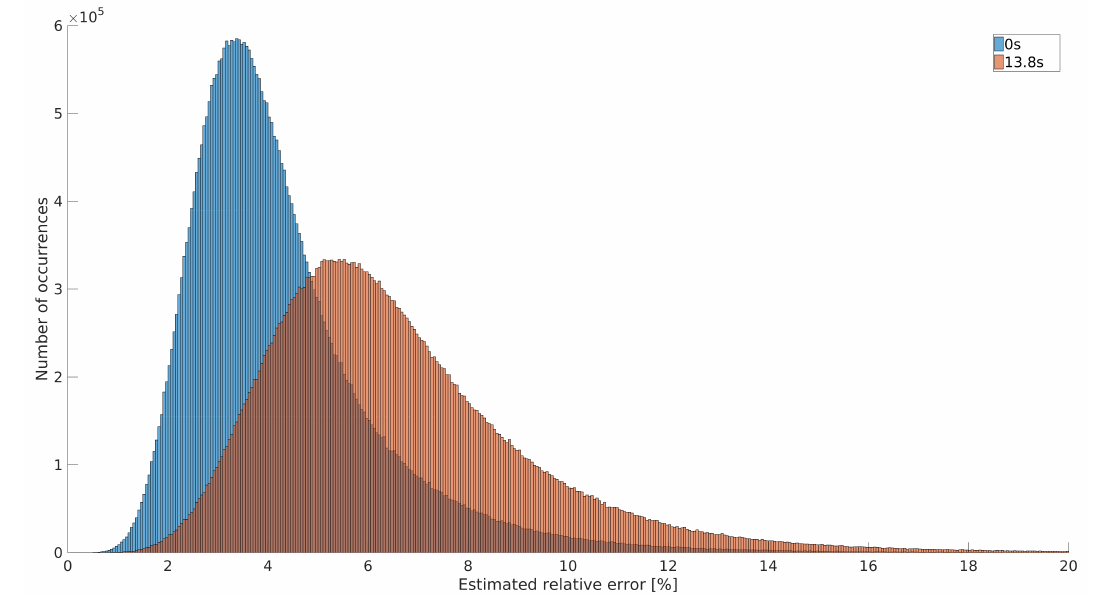
Figure 15. Histogram of node-wise power release relative errors.